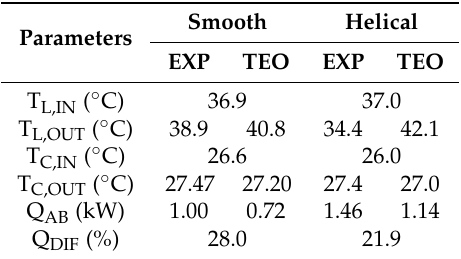
Table 5. Theoretical and experimental data of the absorber.